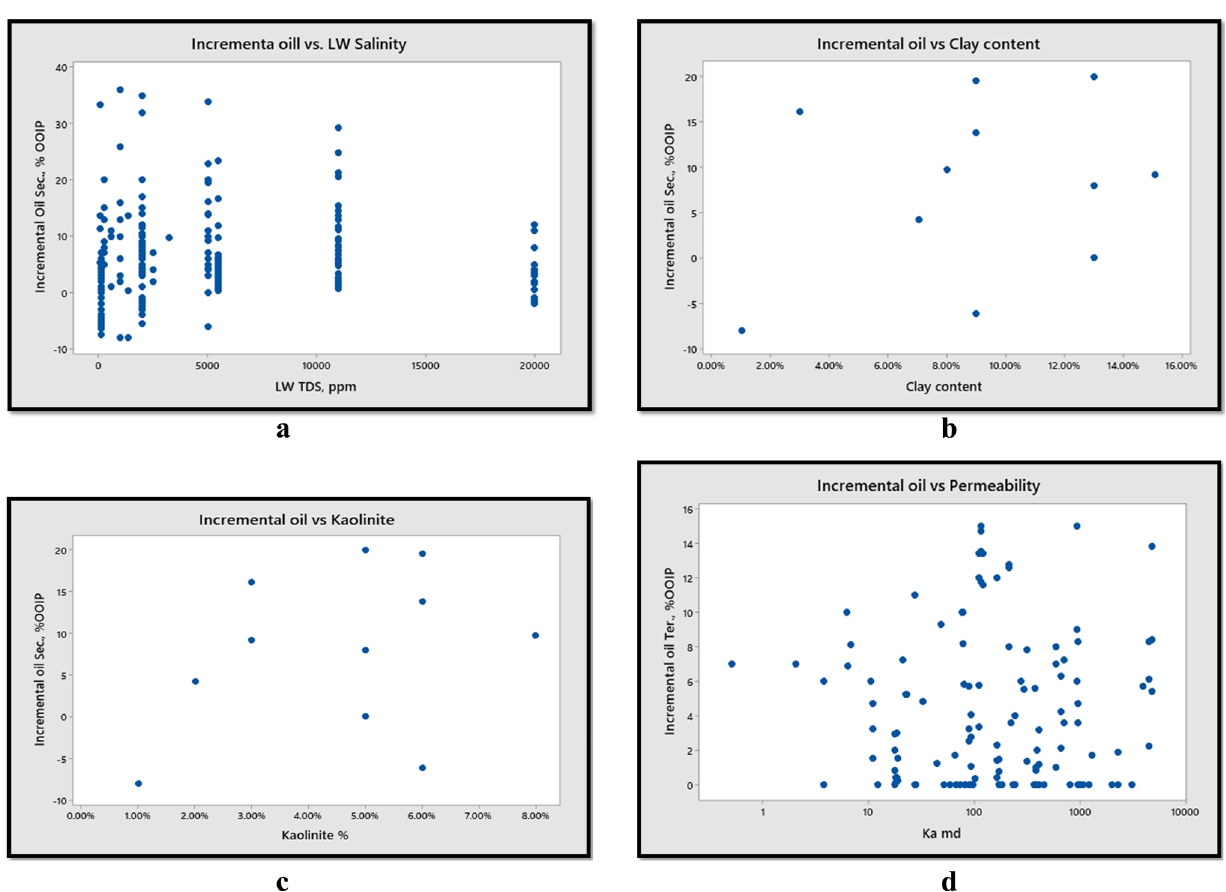
Fig. 3 a Secondary incremental versus LW salinity of the literature data. b Secondary incremental versus clay content of the literature data. c Secondary incremental versus kaolinite of the literature data. d Secondary incremental versus permeability of the literature